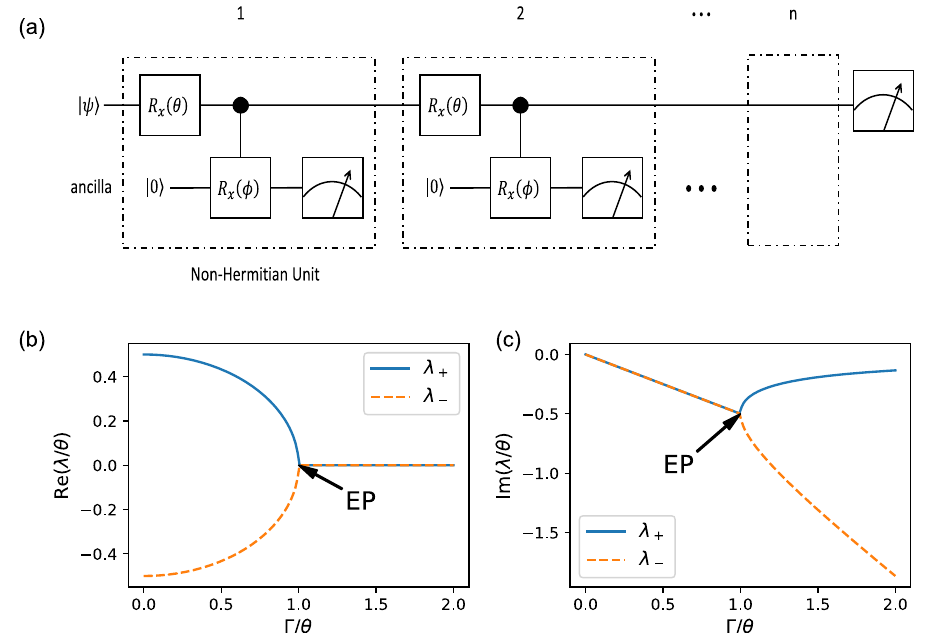
ψ is an arbitrary | � 0 state. We only post-select | � 0 =